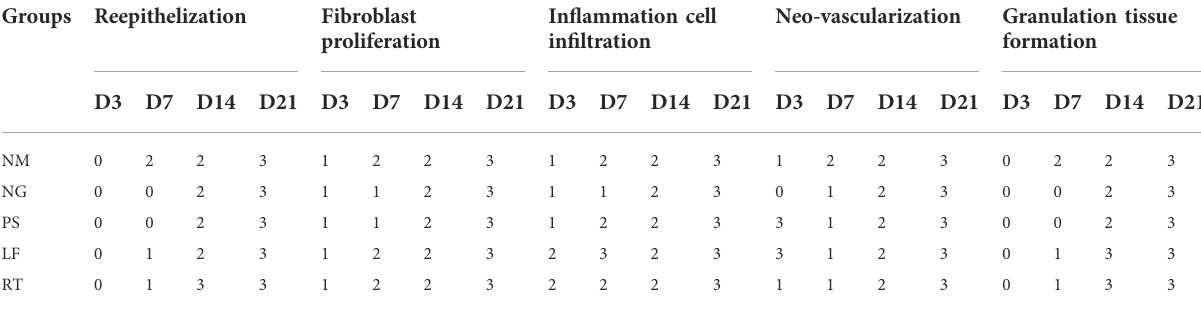
TABLE 4 Scoring from histological observations (H&E) of the burn wounds at Day 3, 7, 14 and 21. Please refer Table 2 for the scoring system. Groups Reepithelization